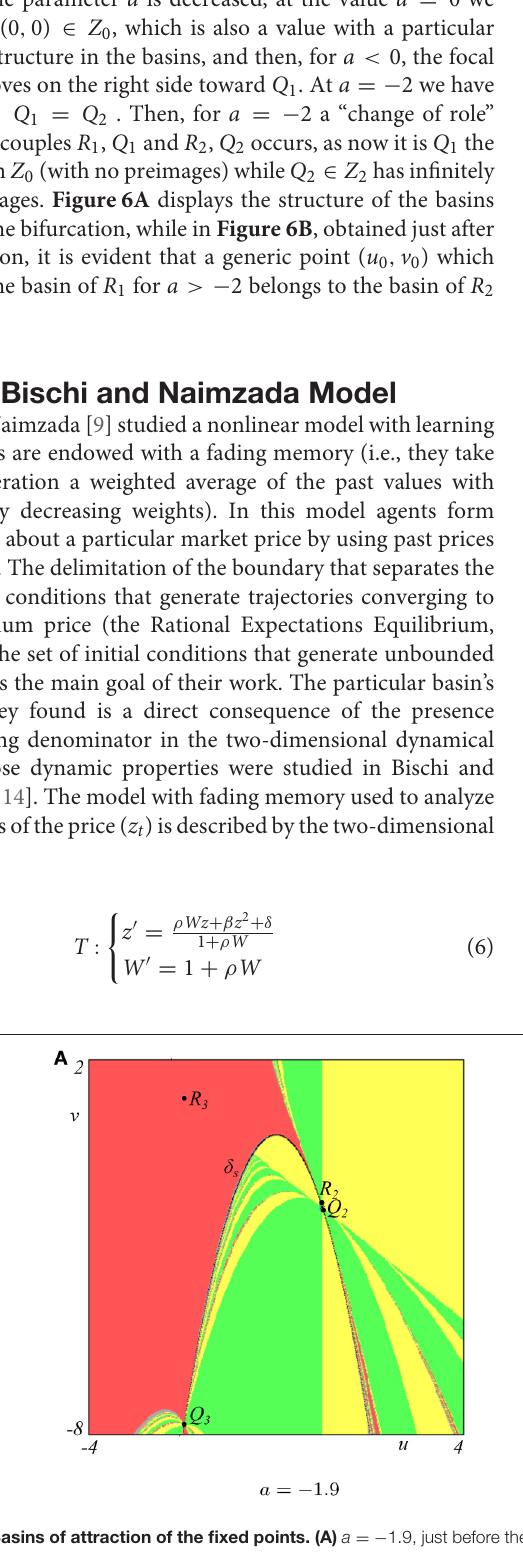
1.9, just before the bifurcation occurring at a = −